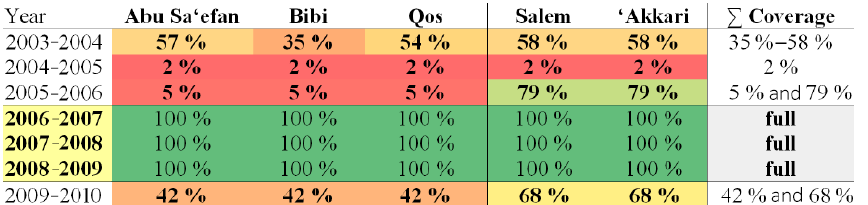
Table C1. Five spring data